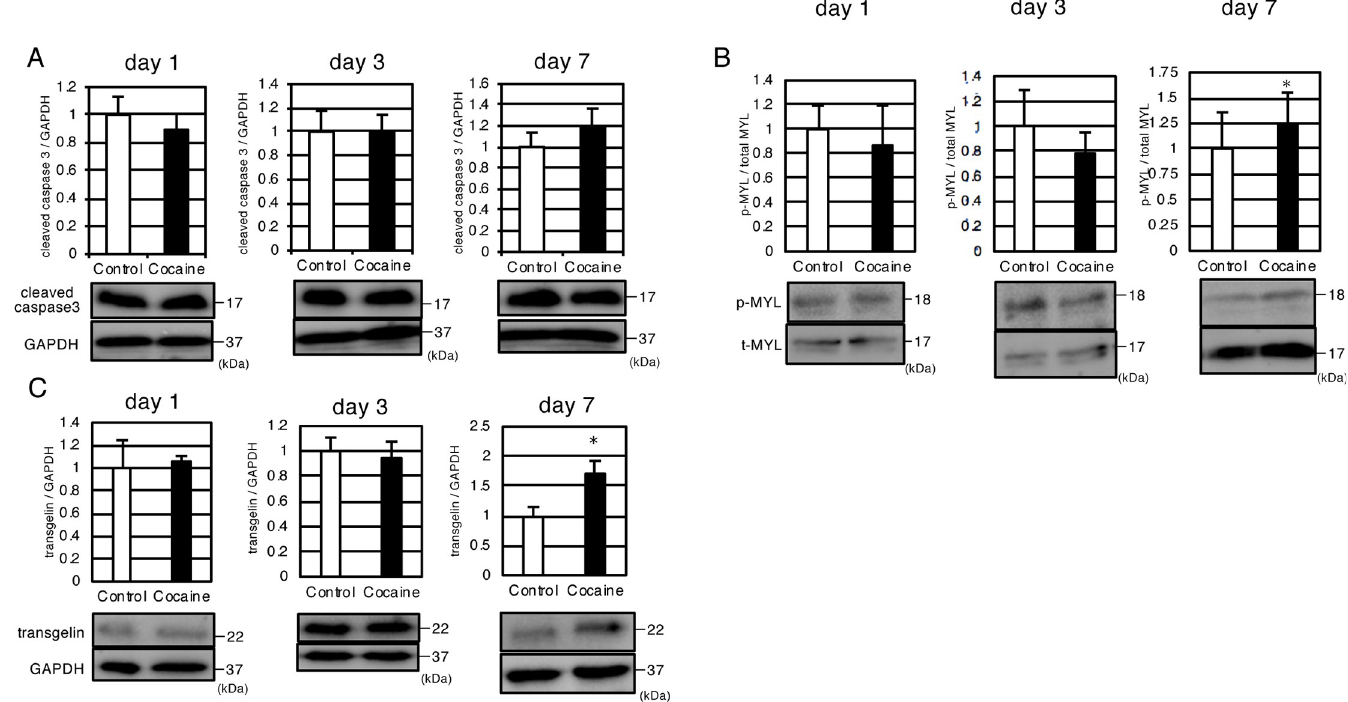
Fig 4. Repeated administration of cocaine upregulates contractile marker proteins, but not a marker of apoptosis in rat spleen. Immunoblot analysis of cleaved caspase 3 (A), phosphorylated as well as total MYL (B) and transgelin (C) in the spleens of rats administered cocaine. GAPDH or actin levels served as internal controls. Graphs show the means and S.D. of 6 samples, except for phosphorylated MYL of the cocaine group of day 7 (5 samples). � P < 0.05 versus control by Student’s t -test.